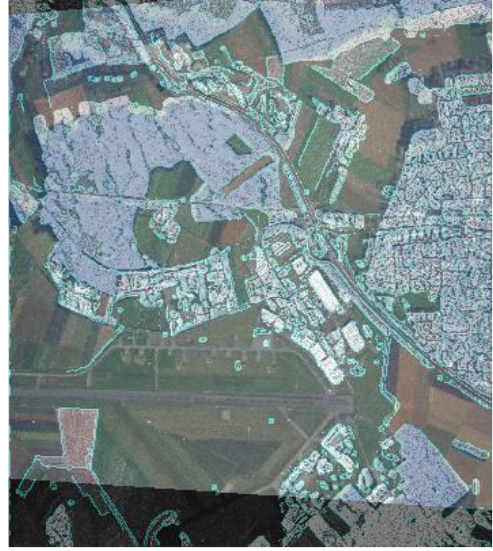
Figure 4 – Fusion of optical and radar